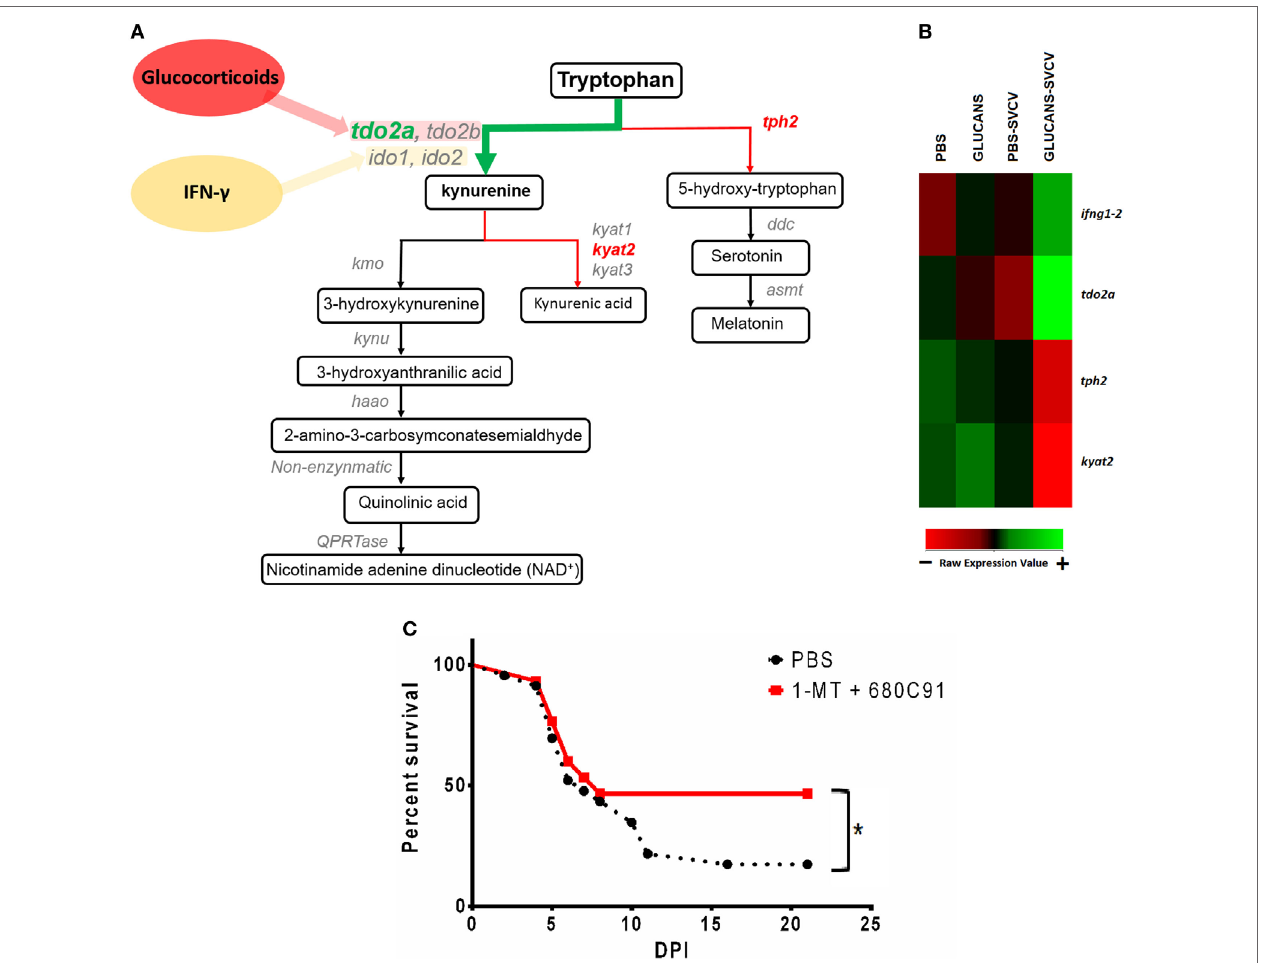
FigUre 7 | Analysis of the kynurenine pathway of tryptophan catabolism in zebrafish inoculated with β -glucans. (a) Schematic representation of the kynurenine pathway and the DEGs in the comparison Glucans-Spring Viremia Carp Virus (SVCV) vs. Glucans-PBS ( tdo2a , kyat2 ) and the comparison Glucans-SVCV vs. PBS ( tph2 ). (B) Heatmap representing some of the most affected genes after β -glucan treatment. Whereas ifng1-2 and tdo2a are highly expressed in the Glucans-SVCV group, tph2 and kyat2 have lower expression levels in these fish. A color gradient scheme representing gene modulation (red: lower expression; green: higher expression) is shown on the bottom. (c) Kaplan–Meier survival curves representing the effect of a TDO-inhibitor (C80C91) and an IDO-inhibitor (1-MT) during a challenge with SVCV in adult zebrafish. A significant increase in the survival rate was observed in individuals inoculated with the inhibitors. Significant differences are represented by asterisks (* p <